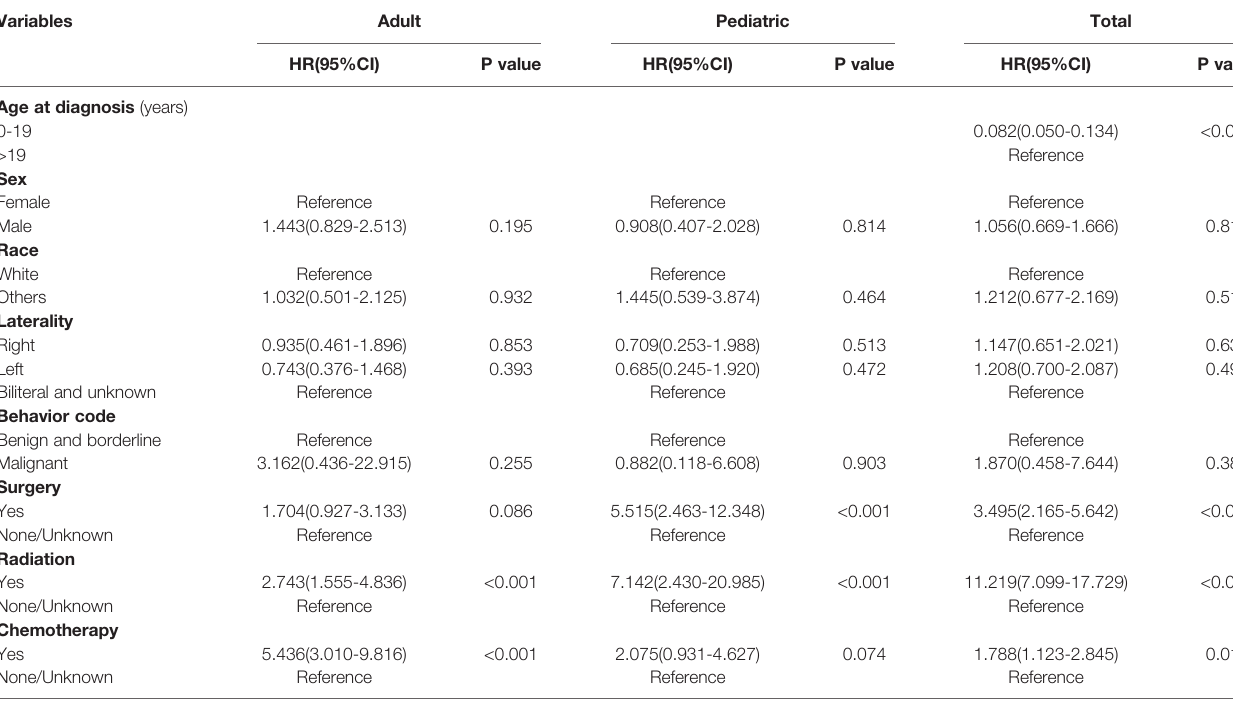
TABLE 5 | The results of the univariate Cox regression analysis.